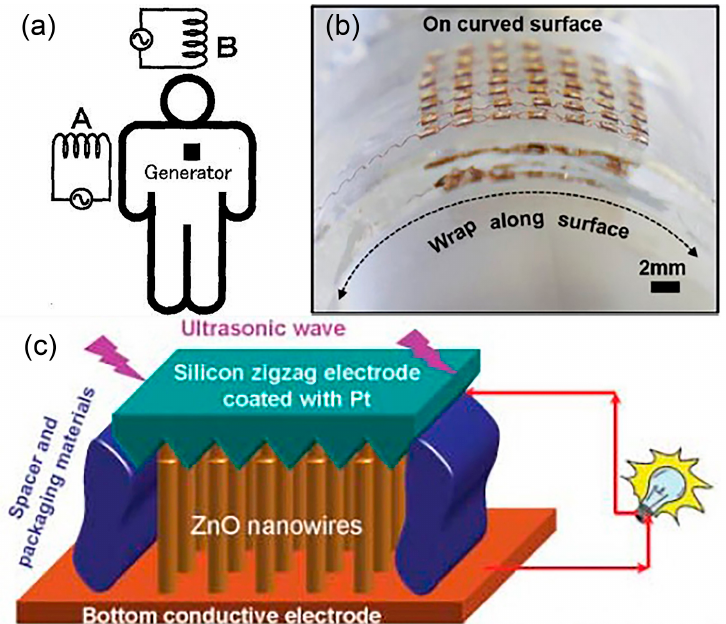
Figure 2. ( a ) Electric power generating system for implanted medical devices is proposed by posi- tioning a human body in a rotating magnetic field. © 1999 IEEE. Reprinted, with permission, from [31]. ( b ) Optical image of the flexible piezoelectric transducers array for ultrasonic energy harvesting. Reprinted from [32], Copyright (2019), with permission from Elsevier. ( c ) A schematic diagram of a nanowire piezoelectric nanogenerator driven by an ultrasonic wave